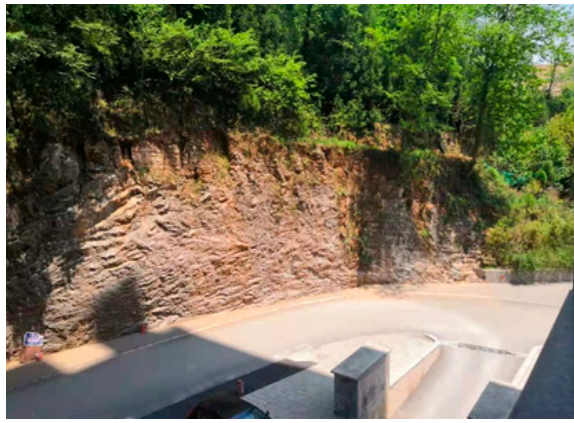
Figure 1. Photo of the slope toe.